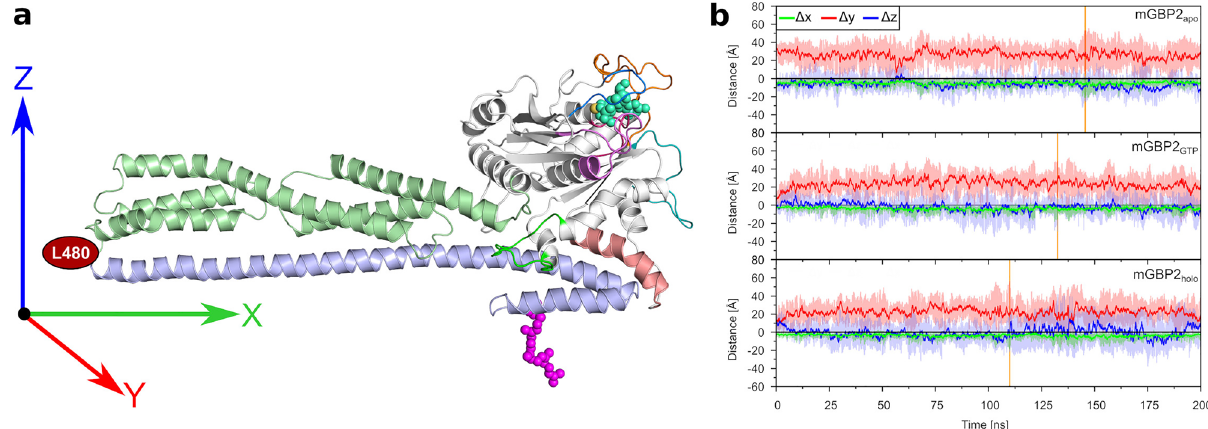
Figure 5. Motions of residue L480 in the HREMD simulations of monomeric mGBP2. ( a ) Reference conformation of the mGBP2 is shown for the calculation of the coordinate distances difference ( (cid:31) x , (cid:31) y , (cid:31) z ) of L480. ( b ) The evolution of these distances ( (cid:31) x : green, (cid:31) y : red, (cid:31) z : blue) is shown for mGBP2 apo (top), mGBP2 GTP (middle), and mGBP2 holo (bottom). The solid lines show the running average and the shades illustrate the raw data. Furthermore, the zero line is shown in black, whereas the vertical orange line indicates the frame with the maximal distance of the L480 residue between reference structure and 200 ns HREMD